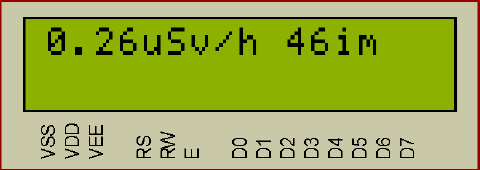
Figure 7. Simulation of the microcontroller-based system for background radiation monitoring (radiometer operation mode).